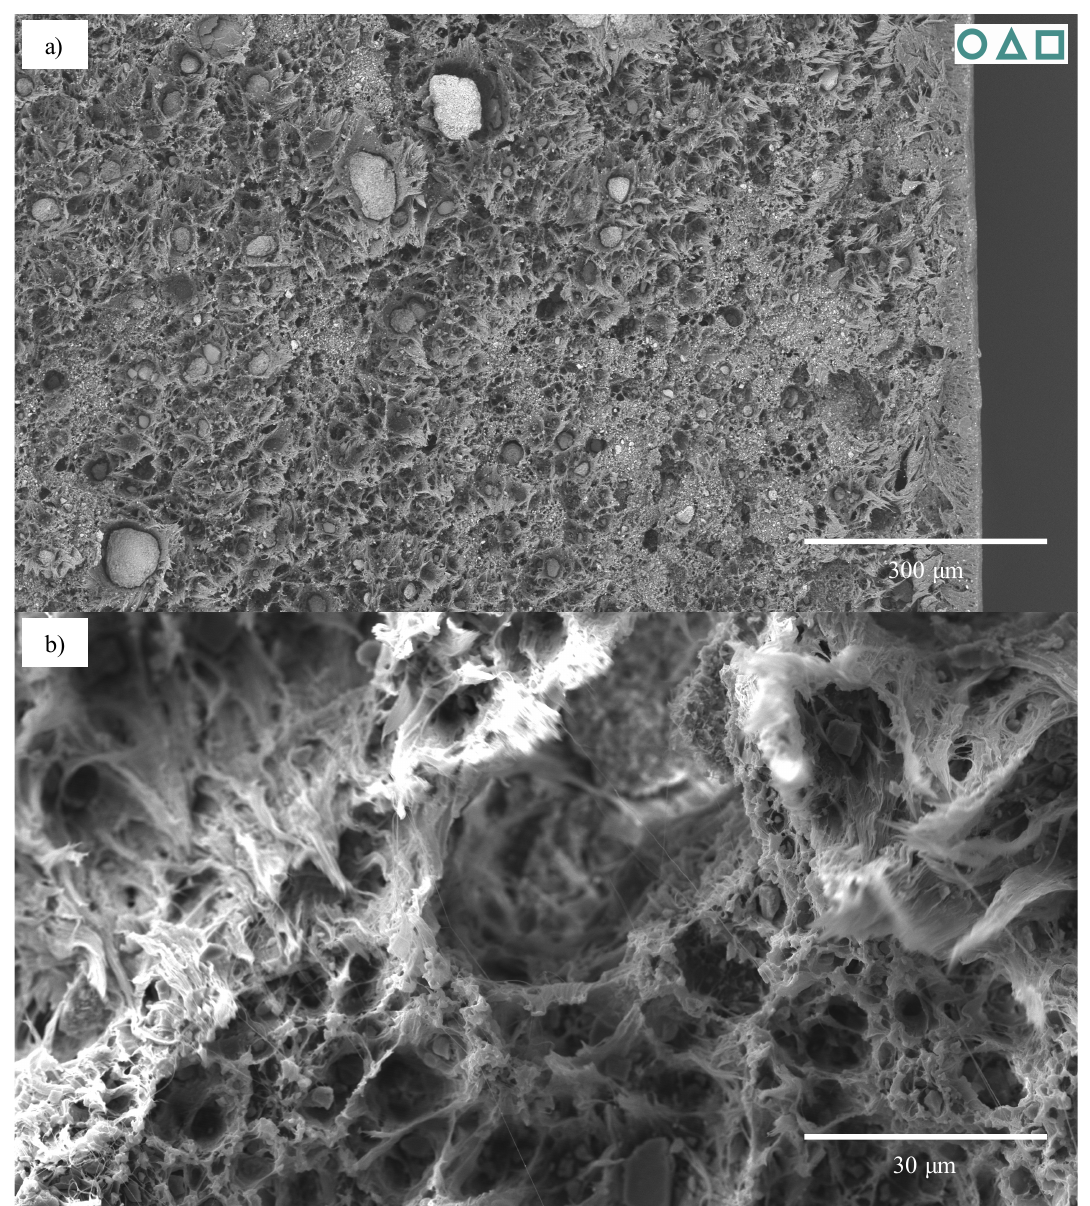
Figure 24. SEM micrographs of the failure regions of a 1.8-CB/30-CC/0.25-SP WL specimen: ( a ) general morphology showing a progression of mechanism moving away from the perimeter; ( b ) detail of fibrillation and particle effects, with much-reduced fibrillar